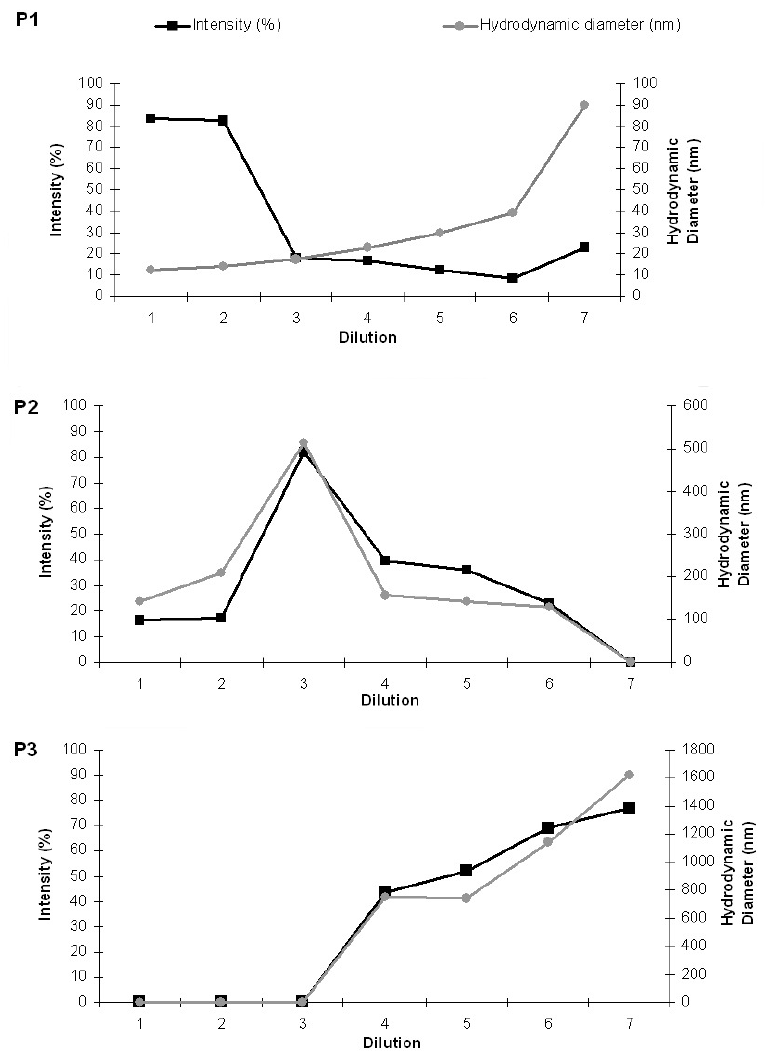
Figure 12. Evolution of the DLS scattered intensity and hydrodynamic diameter of the DPPC/DHPC bicelles upon dilution. P1 denotes the evolution of particles with sizes in the range of 10–100 nm ( A ). P2 denotes intermediate sized particles with diameters around 100–500 nm ( B ) and P3 indicates the bigger particles >500 nm ( C